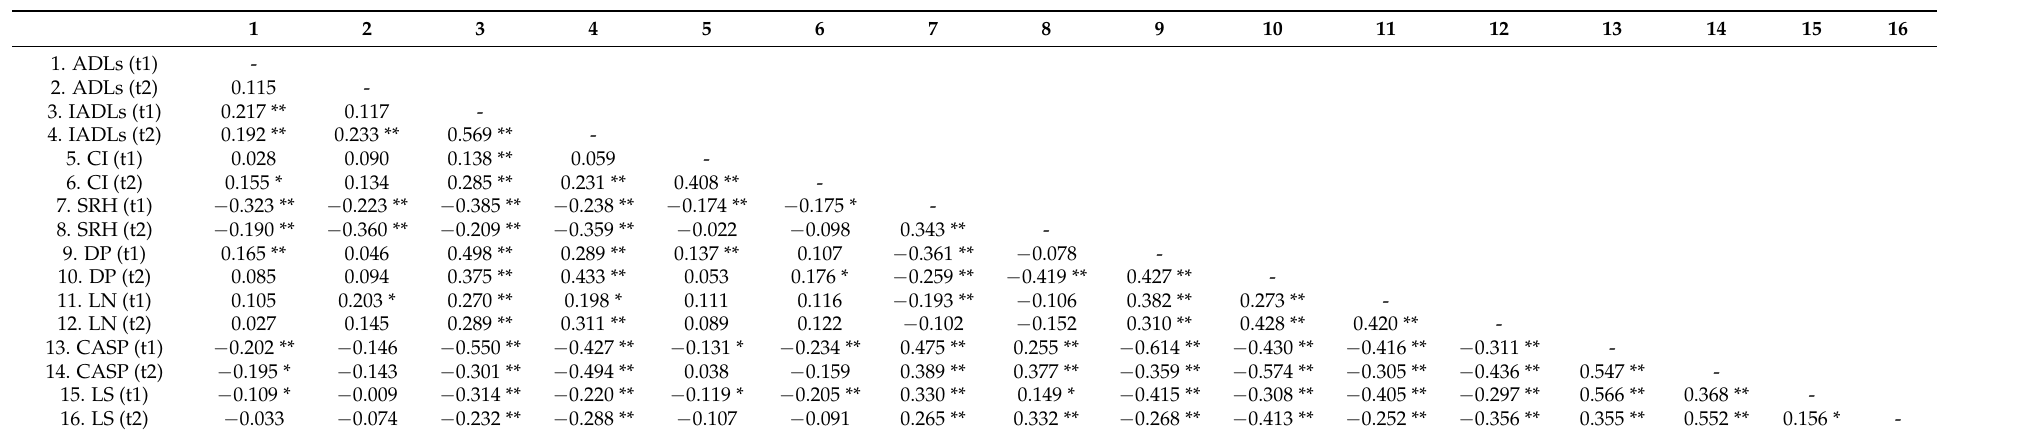
Table A1. Pearson’s correlations between the latent